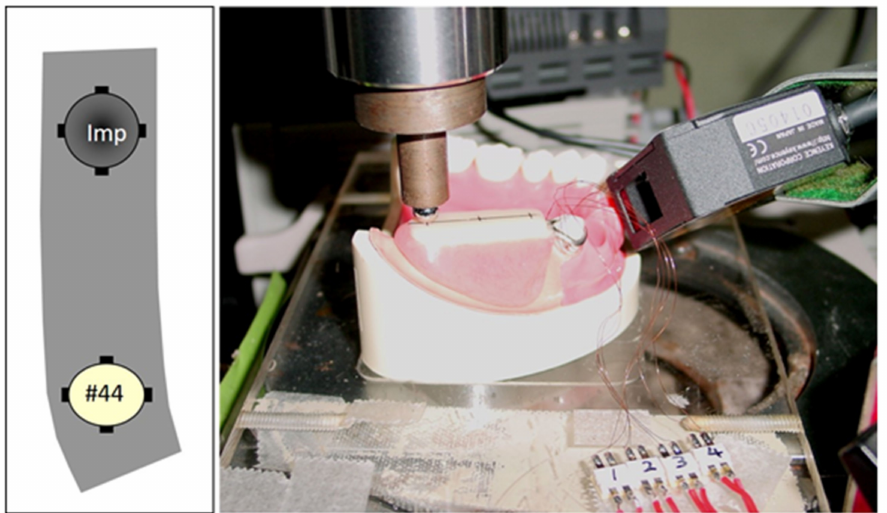
Figure 3. Schema and image of biomechanical analyses. Four strain gauges were attached to the implant and artificial tooth root surface. Biomechanical behaviors under a vertical load of 100 N by autograph at each loading point were recorded and